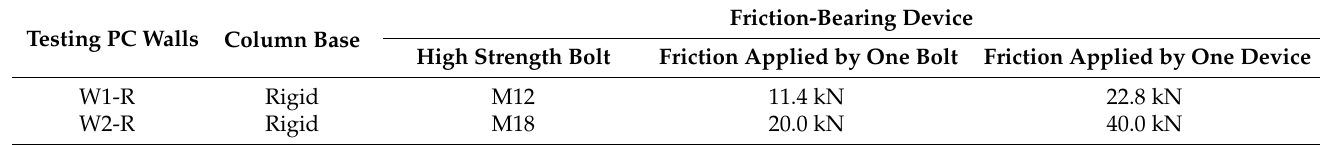
Figure 8. Details of vertical connection in PC walls (unit: mm). ( a ) W1-R; ( b ) W2-R. Table 1. Details of vertical